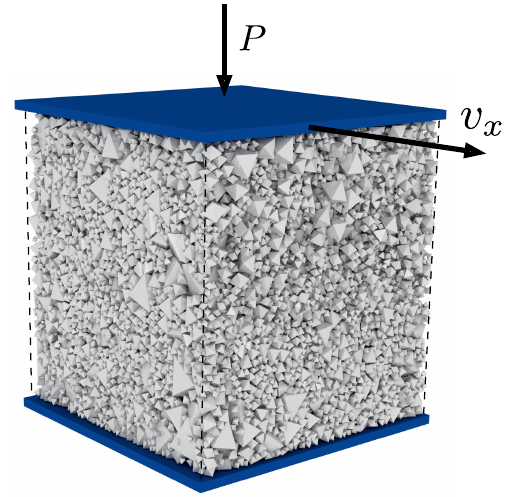
Figure 1. Screenshots of samples with a grain size dispersion S = 0 . 8.